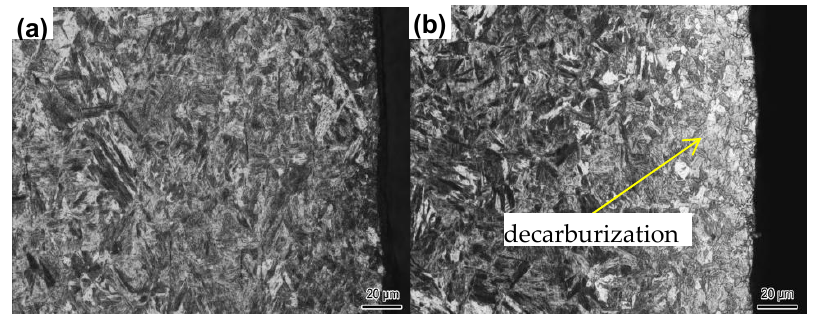
Figure 11. Surface topography of hot-stamped parts of 20Mn2Cr ( a ) and 22MnB5 ( b ).